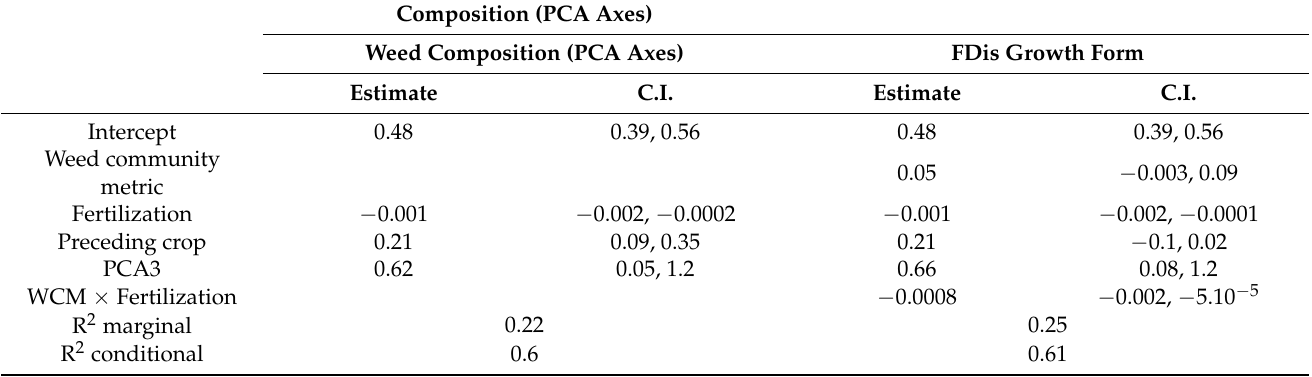
Table 4. Estimates, confidence intervals (C.I.) and R 2 marginal and conditional values of the M1 model (taking into account management and climatic variables along with PCA axis), and of the model for which the inclusion of a weed community structure metric improved the parsimony in explaining the glutenin to gliadin ratio in wheat